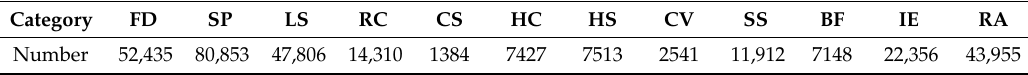
Table 1. The number of points of interest (POIs) for each category in